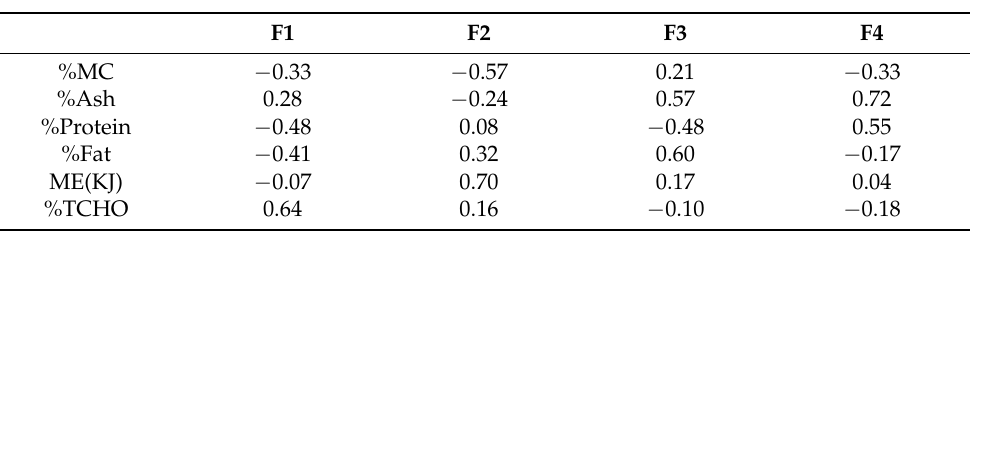
Table 4. Eigenvectors for the principal component